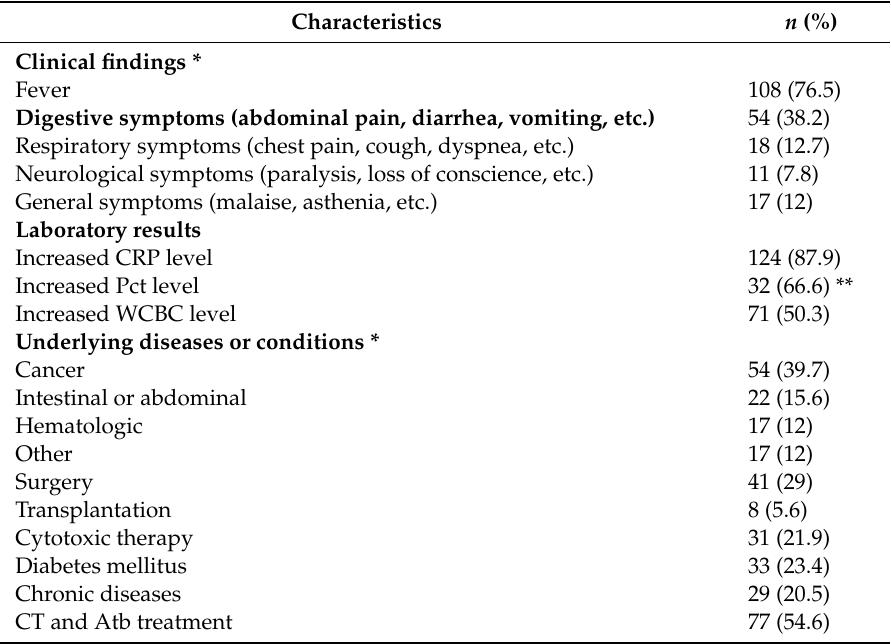
Table 1. Characteristics of 141 patients with bloodstream infection caused by anaerobic microorganisms.